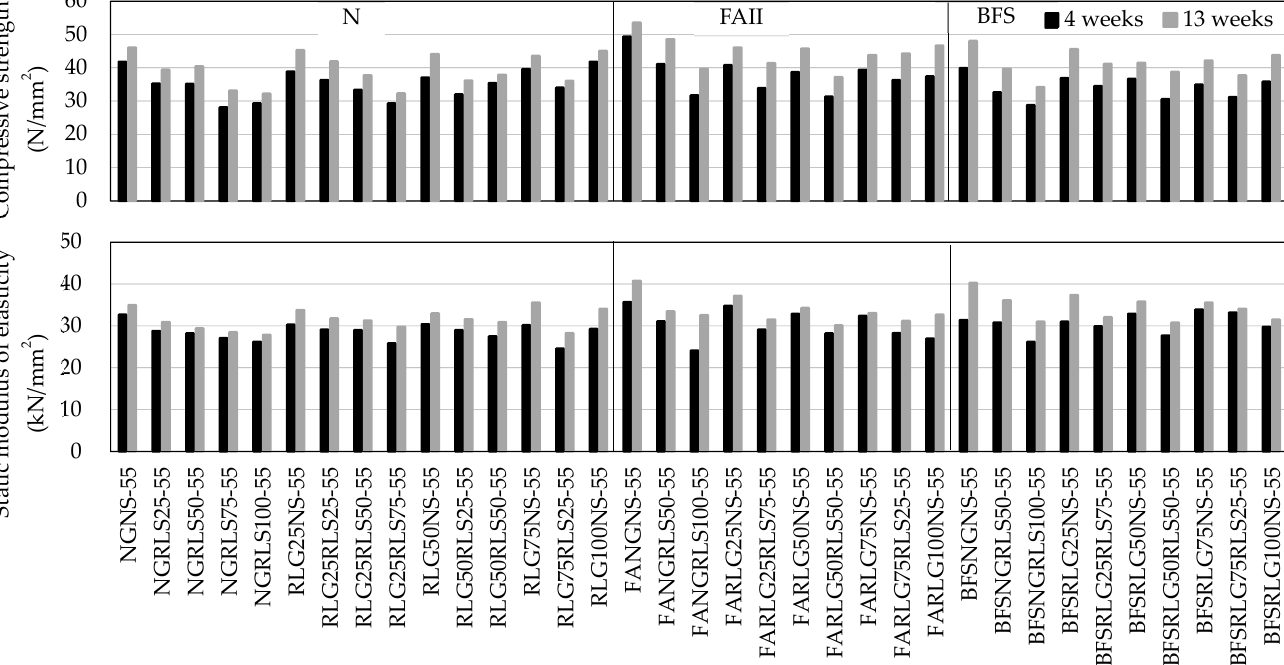
Figure 6. Compressive strength and static modulus of elasticity of concrete.